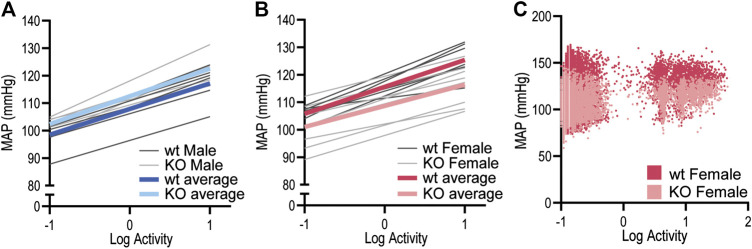
Relationship between MAP and locomotor activity in GPR37L1−/− mice. Linear regressions for mean arterial pressure (MAP) vs. log-locomotor activity in male (n = 6–7) (A) and female (n = 7–8) (B) GPR37L1−/− (KO; light gray) and wildtype (wt; C57BL/6J; dark gray) mice during baseline radiotelemetry recordings over a 12-h period (6 h of dark and 6 h of light), with colored lines representing average regression for each genotype. Representative plot of 2-s averages of log-locomotor activity against 6-s-offset MAP over the 12-h period for one wildtype female (darker red) and one GPR37L1−/− female (lighter red) (C).